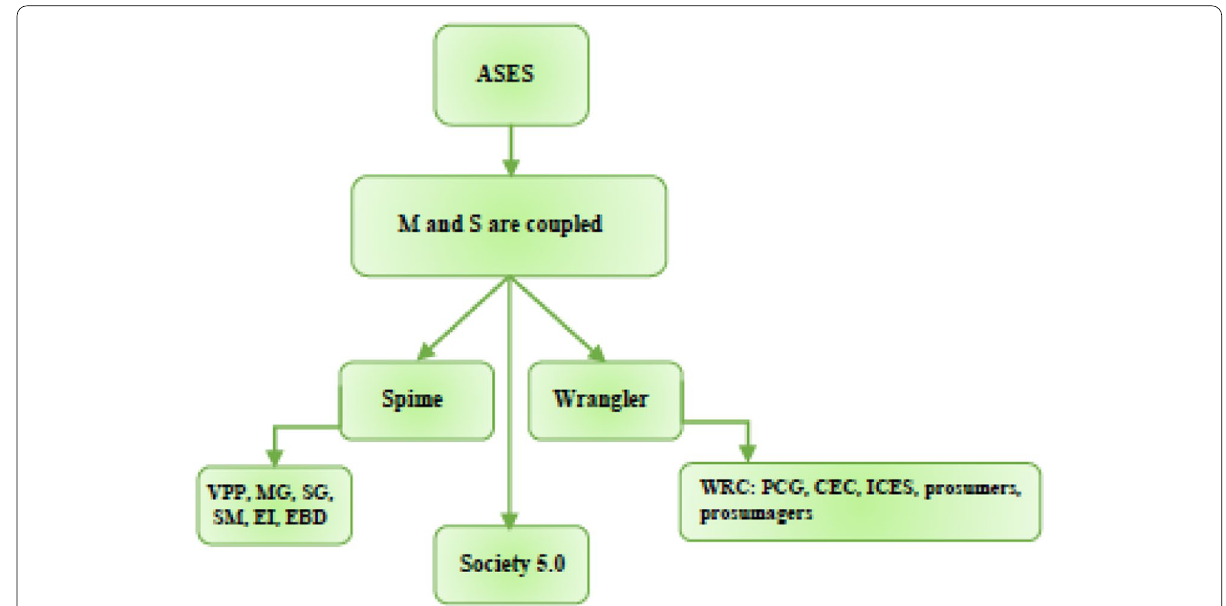
Fig. 4 Realization of coupling between M and S in